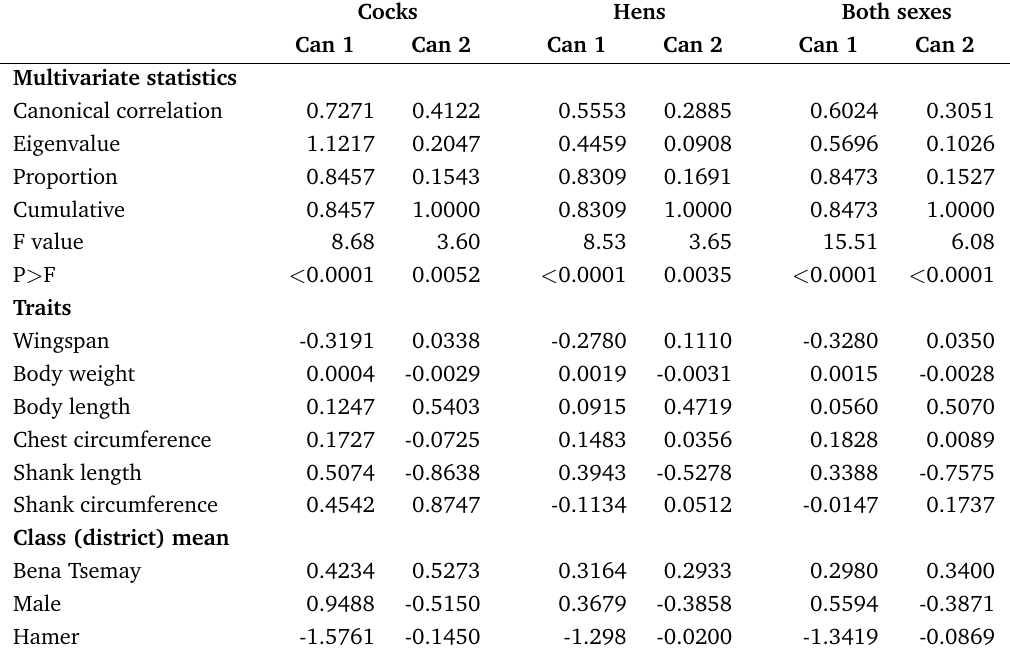
Table 11. Multivariate statistics, canonical coefficients of the quantitative variables, and class means outputs of the two canonical structures separately for each sex. Can = Canonical